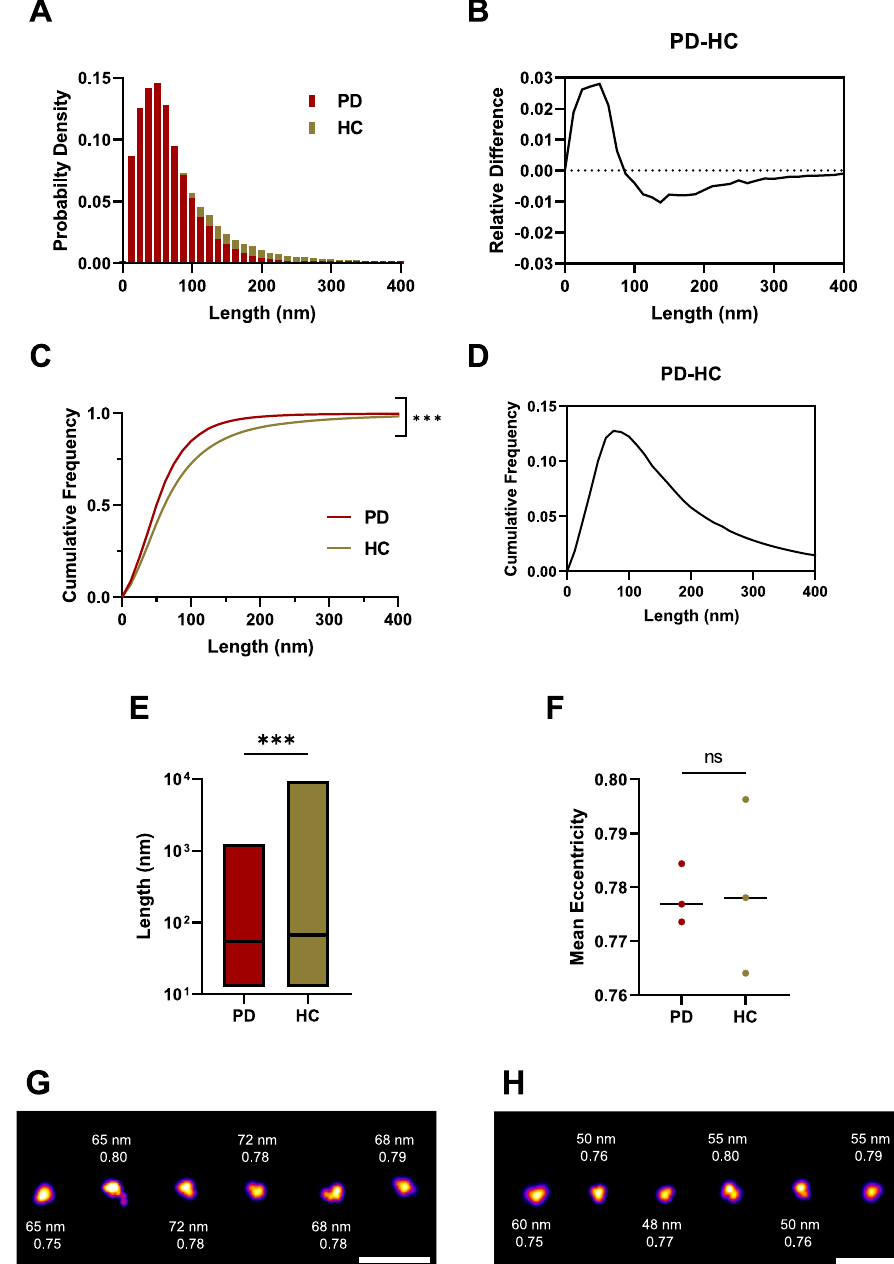
Fig. 7 | The soluble aggregates extracted from PD and control brains have different sizes as super-resolved with AD-PAINT. A Histogram of the size dis- tributionforPD(burgundy, N =54218)andcontrolbrain-derivedaggregates(beige, N =48222). Each histogram is the collected data from three cases. B Difference between the histograms for size distribution. C Cumulative frequency distribution foraggregatelengthforPDandcontrols.Eachhistogramisthecollecteddatafrom three cases (Kolmogorov-Smirnov test, p <0.001 for PD versus controls). D Difference between the cumulative frequencies for the size distribution. E Boxplot comparing aggregate length in PD versus controls. Box limits represent